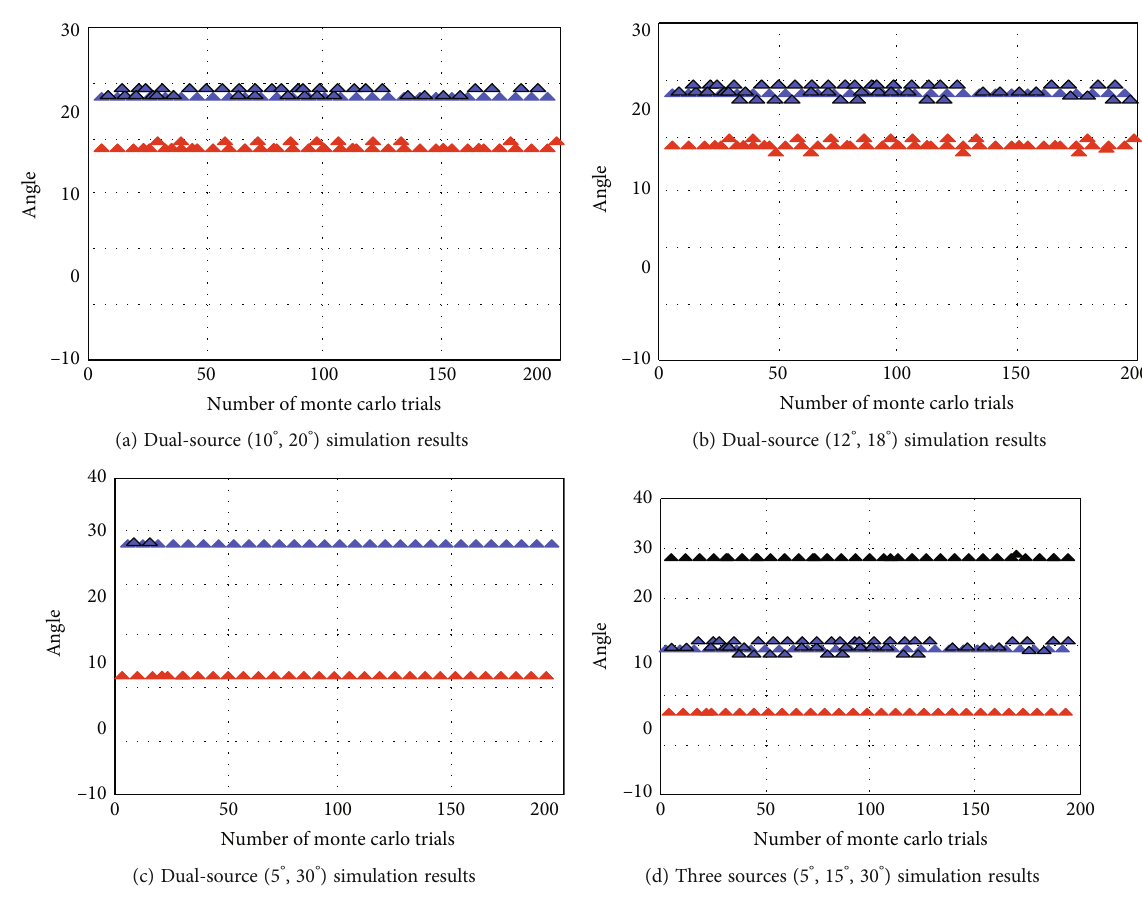
Figure 6: Multisource DOA simulation result of T-matrix fast reconstruction